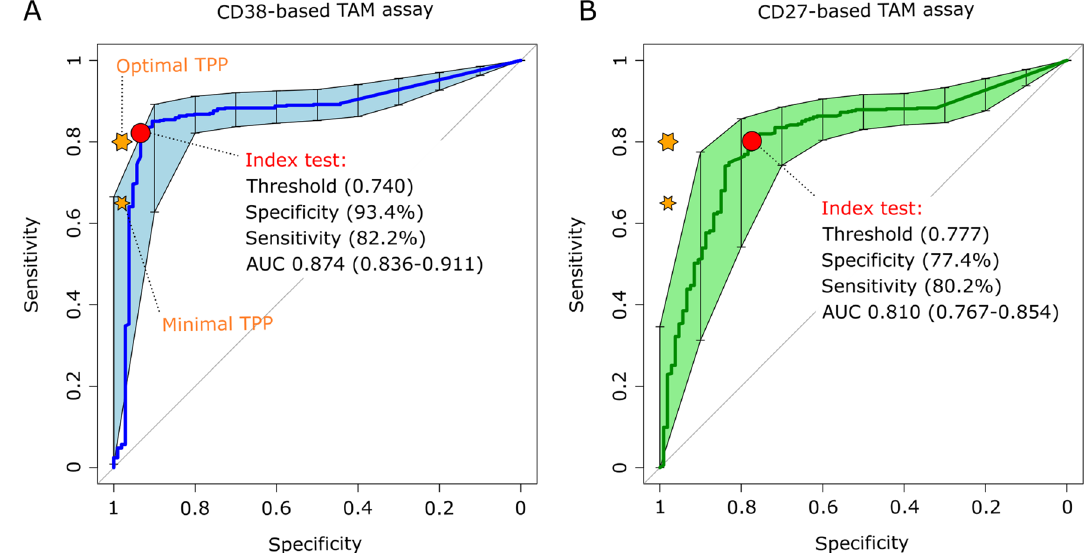
Figure 3. Receiver operating characteristic (ROC) curves of CD38-based (left plot) and CD27-based index test. The orange stars indicate the target product profile (TPP) minimal (80/98) and optimal (65/98) sensitivity/ specificity values defined by WHO for non-sputum confirmatory TB diagnostic tests. The red circles indicate the index test performance and threshold values yielding the best specificity for a test sensitivity above 80%, the minimal TPP requirement. AUC, area under the curve and 95% confidence intervals within brackets.